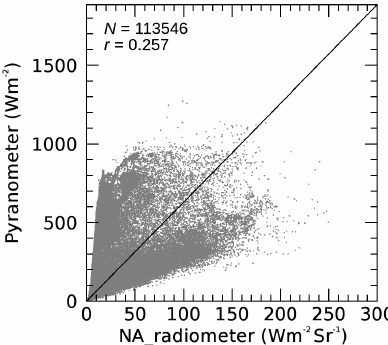
Figure 6. Scatterplot of broadband radiances and irradiances ob- served with a narrow-angle radiometer and a wide-angle pyranome- ter at Chiba (35.62 ◦ N, 140.10 ◦ E) during January–March 2016. The solid line represents y = 2 πx